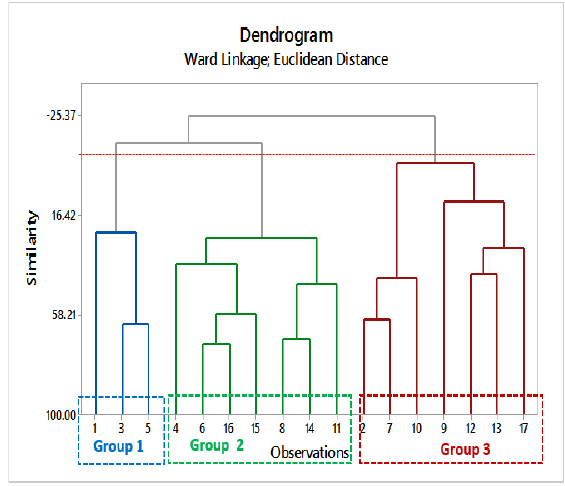
Figure 5. Dendrogram showing the similarity among avocado plantations of the Chavimochic irrigation project in 2017.